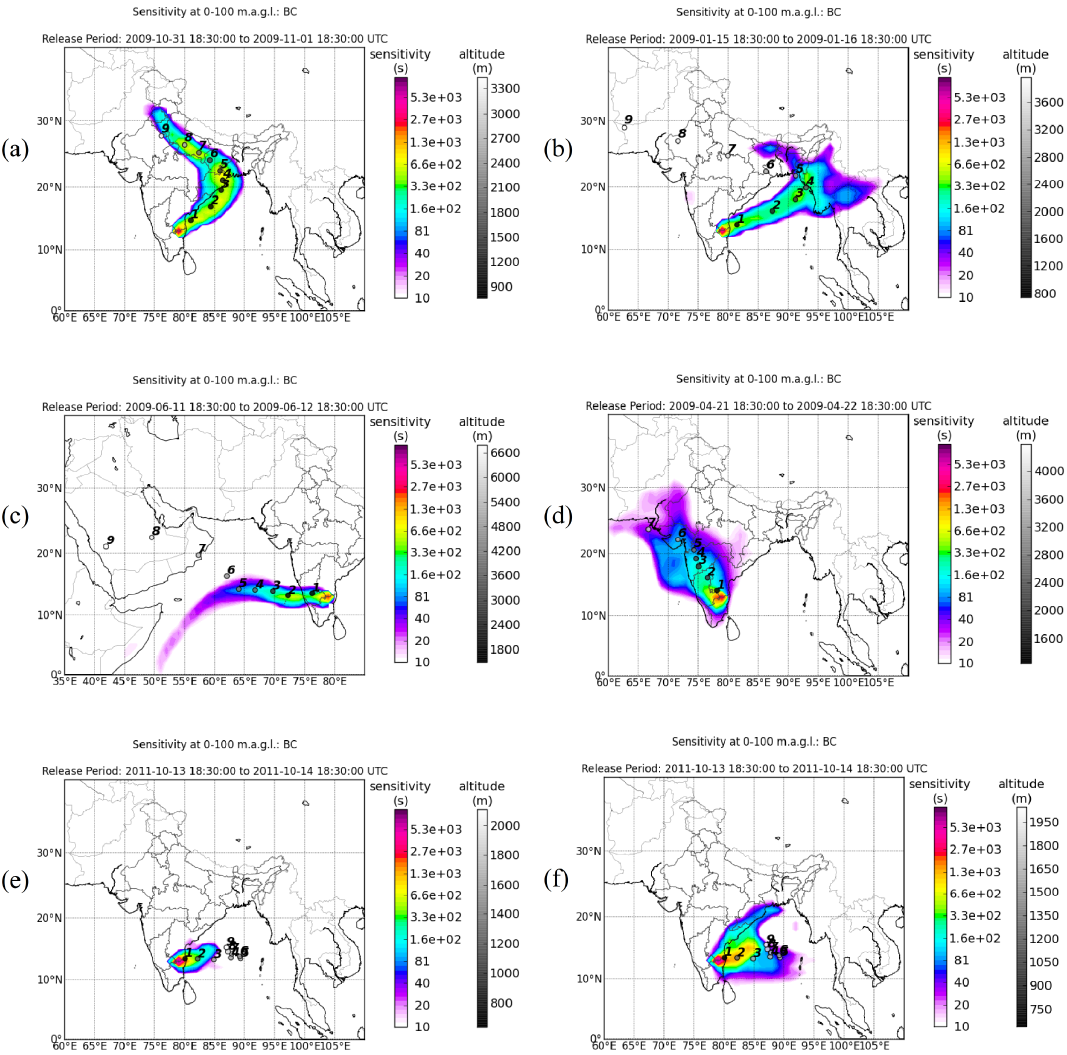
Figure 5. Selected examples of footprint potential emission sensitivity (PES) maps (also known as source–receptor relationships) using 10 days of backward runs (retroplumes) of FLEXPART from Gadanki. Panels (e) and (f) are PES maps of 14 October 2011 local time with and without wet deposition respectively. See Supplement for the PES maps for other